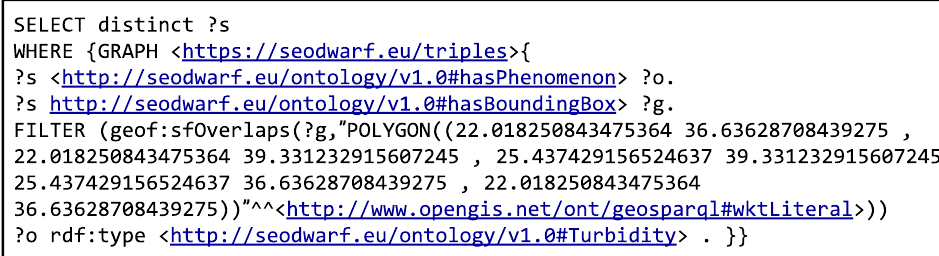
Figure 4. Example of SPARQL query built by SeMaRe